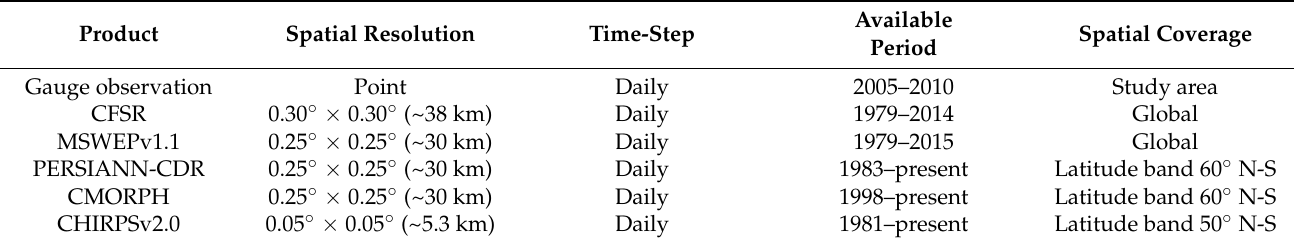
Table 1. List of precipitation datasets